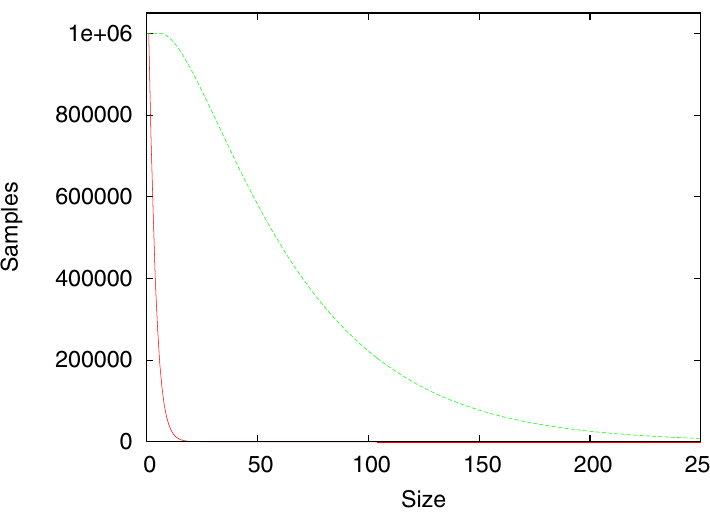
Fig. 3. Attrition of started walks generated with Rosenbluth Sampling compared with Simple Sampling. Walks with a few hundred steps become